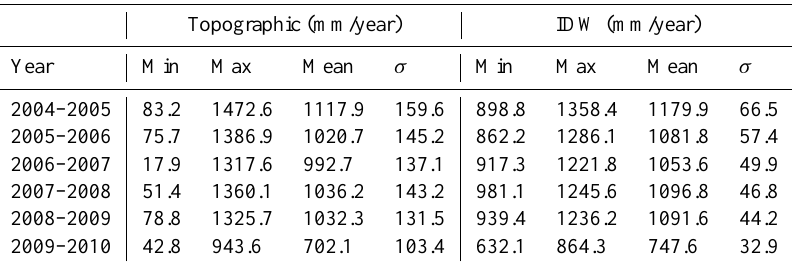
Table 7. Maximum, minimum, mean and standard deviation (mm/year) of annual evapotranspiration estimates in the watershed on selected days with global radiation topographically corrected and IDW interpolated Topographic (mm/year) IDW (mm/year)